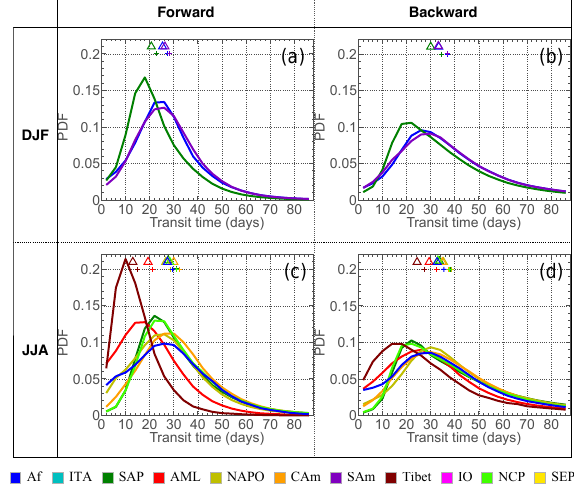
Figure 4. Distribution of the transit times in boreal winter (DJF) and boreal summer (JJA) for forward and backward calculations. The vertical axis is a probability density function in day − 1 . Curves are plotted according to the color code of Fig. 1 but only for the active convective regions during each season. In the upper part of each panel, the triangles and the crosses indicate, respectively, the median and the mean for each